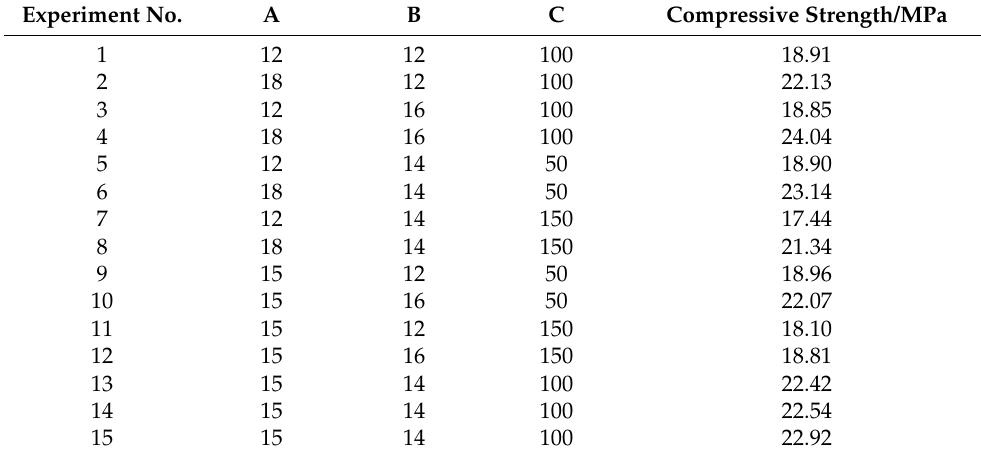
Table 3. Experimental design and results of response surface method.